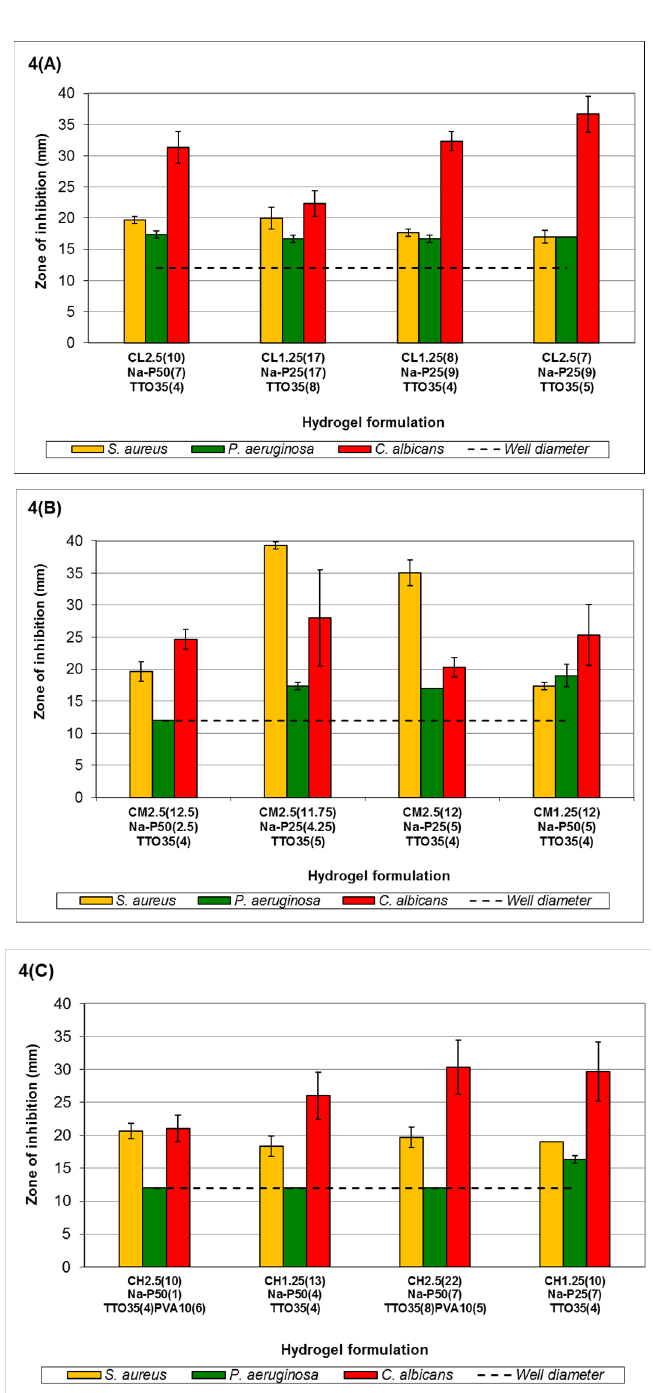
Figure 4. Antimicrobial activity of TTO-hydrogels formulated with ( A ) low viscosity chitosan, ( B ) medium viscosity chitosan and ( C ) high viscosity chitosan. Error bars represent the standard deviation and n = 3. In all control experiments (using hydrogels without TTO), there was no observed zone of inhibition (ZOI) (data not shown). Statistical analysis using ANOVA indicated a significant difference in the antimicrobial activity of the formulations against the selected microorganisms ( p < 0.05). The codes shown in the figure key describes the following: C L1.25 = 1.25% w / v low viscosity chitosan, C L2.5 = 2.5% w / v low viscosity chitosan, C M1.25 = 1.25% w / v medium viscosity chitosan, C M2.5 = 2.5% w / v medium viscosity chitosan, C H1.25 = 1.25% w / v high viscosity chitosan, C H2.5 = 2.5% w / v high viscosity chitosan, Na-P 25 = 25% w / v sodium phosphate, Na-P 50 = 50% w / v sodium phosphate, TTO 35 = emulsion of TTO:PVA 30 ‐ 70 (35:65 v / v ratio), PVA = PVA 30 ‐ 70kDa and the volume of the components used in each formulation are shown in the brackets.